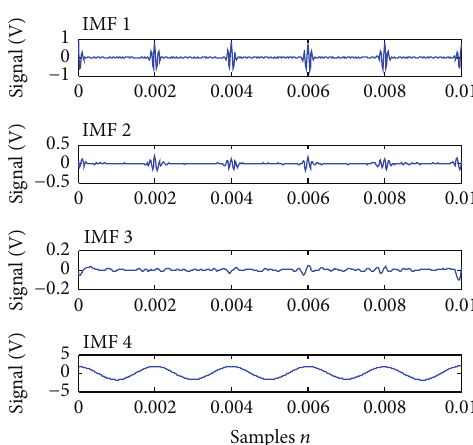
Figure 2: The decomposition result by CEEMD.